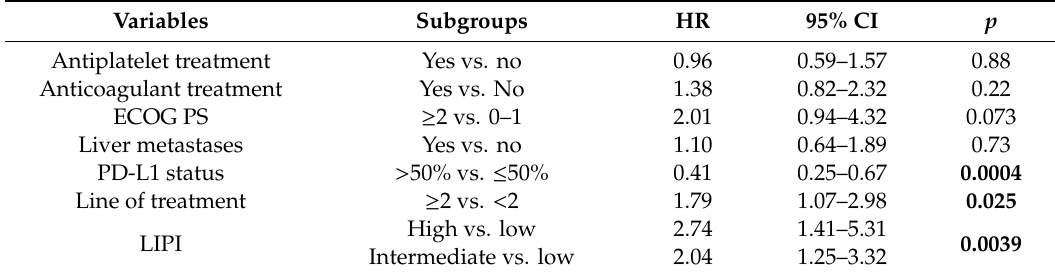
Figure 5. Progression-free survival according to anticoagulant treatment. Table 8. Multivariate Cox proportional hazards models for progression-free survival.